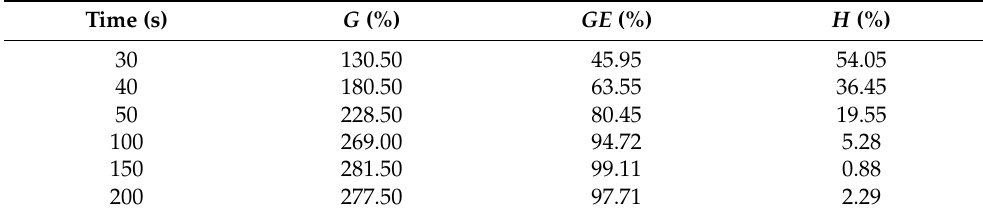
Table 6. Effect of irradiation time on grafting parameters (Power = 750 Watt; mxan = 0.2 g/L; mAAm = 8.0 mmol).